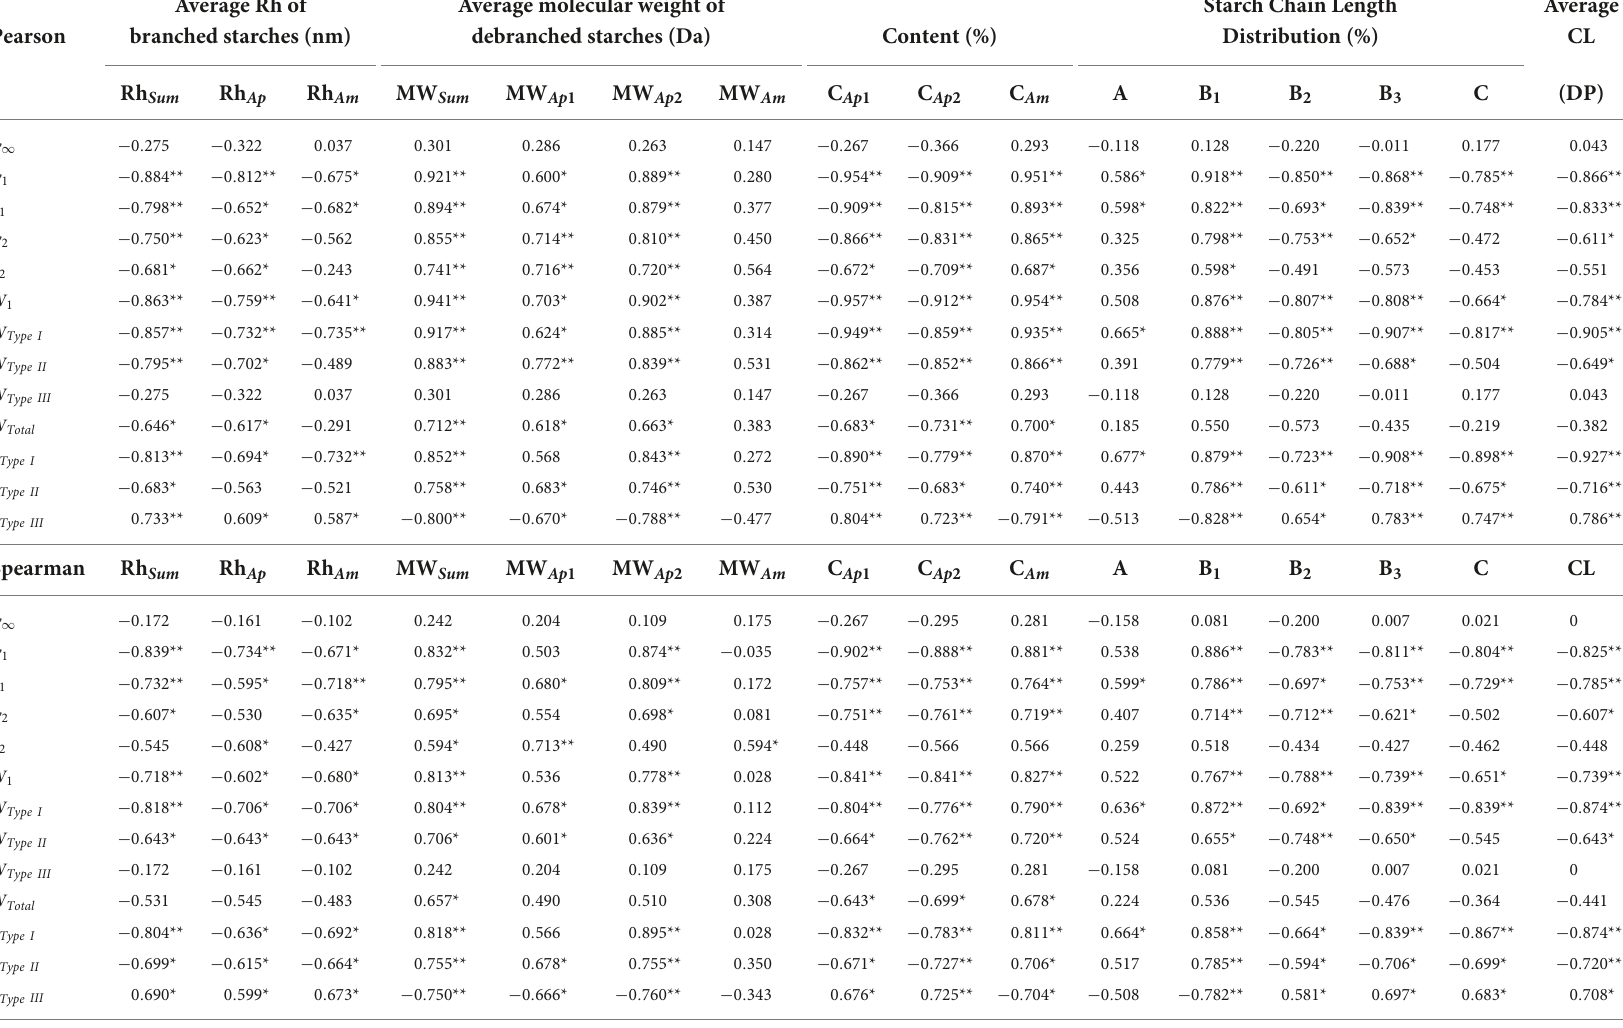
TABLE 4 Correlation coefficients between starch fine structure and simulated oral processing of cooked japonica rice. Average Rh of Average molecular weight of Starch Chain Length Average